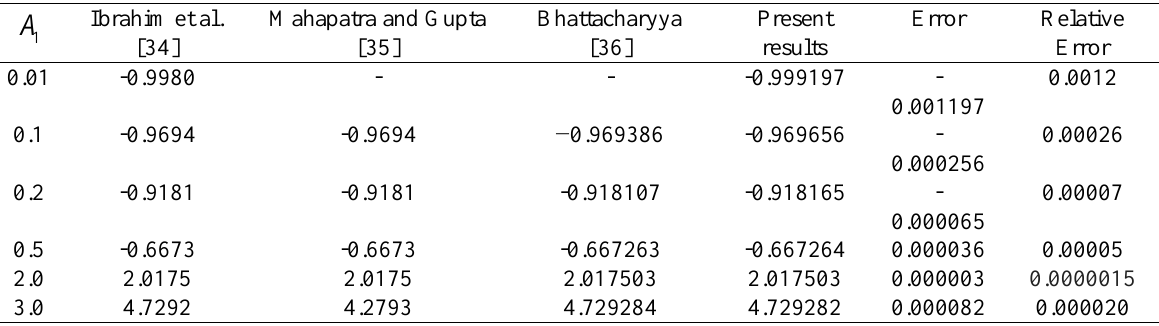
Table 2. Comparison of the numerical values of   0 f  for M=0,A=0,n=1, Pr=1, =0,  S=0,K  